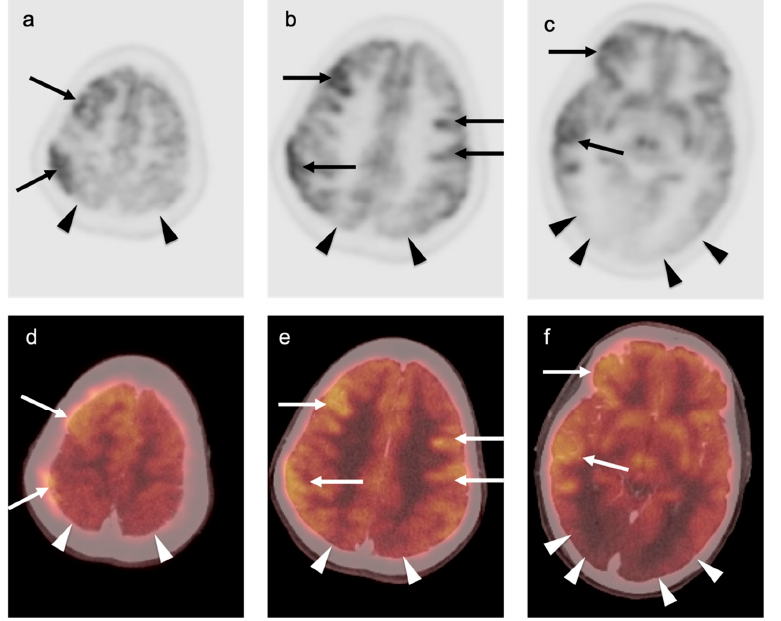
Figure 35. Anti ‐ NMDAR encephalitis. The patient presented with seizures and psychiatric disturbances. Anti ‐ NDMAR Ab titers: serum 1:40, CSF 1:120. MRI imaging was unremarkable. Whole ‐ body FDG PET ‐ CT imaging was negative for sites of tumor involvement, so that the etiology was likely autoimmune. ( a – c ) Axial FDG PET images demonstrate scattered cortical areas of increased metabolic activity (black arrows) with global decreased metabolic activity within the posterior cerebrum (black arrowheads). ( d – f ) Fused axial FDG PET ‐ CT images demonstrate similar findings to non ‐ fused imaging, with scattered cortical areas of hypermetabolism (white arrows) and global decreased metabolic activity in the posterior cerebrum (white arrowheads). Anti ‐ NMDAR encephalitis can be either paraneoplastic or autoimmune in etiology.